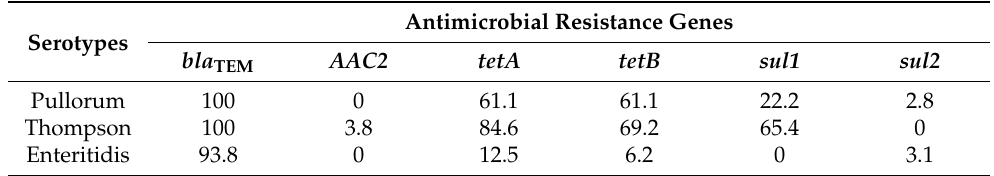
Table 7. Detection rates of antimicrobial resistance genes among the three different serotypes (%). Serotypes